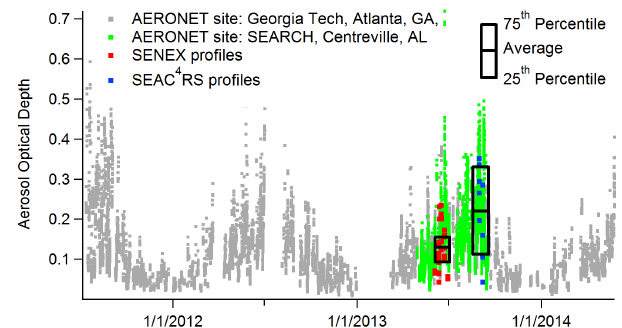
Figure 14. The AOD measured by AERONET sun photometers in Atlanta, GA (gray), and Centreville, AL (green), and the AOD from the SENEX (red) and SEAC 4 RS (blue) profiles included in the altitude-normalized aggregate are shown. The black boxes show the average, 25th, and 75th percentiles of AOD from both the SENEX and SEAC 4 RS